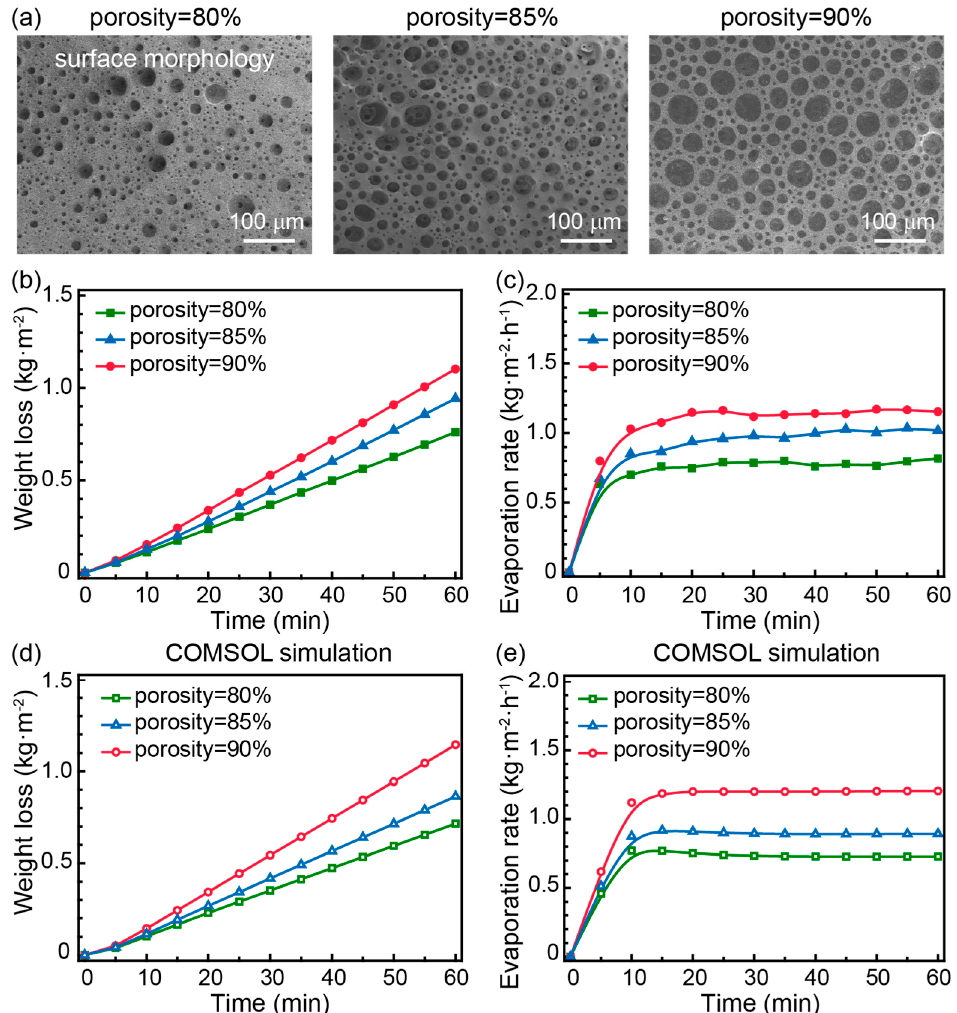
Figure 5. Effects of porosity on the performances of water evaporation using APEG-TPEs. ( a ) SEM images of APEG-TPEs with a porosity = 80%, 85% and 90%, respectively. ( b ) Accumulative water losses and ( c ) evaporation rates of APEG-TPEs with different porosity as a function of irradiation time. COMSOL simulations of ( d ) accumulative water losses and ( e ) evaporation rates of APEG-TPEs with different porosity as a function of irradiation time.